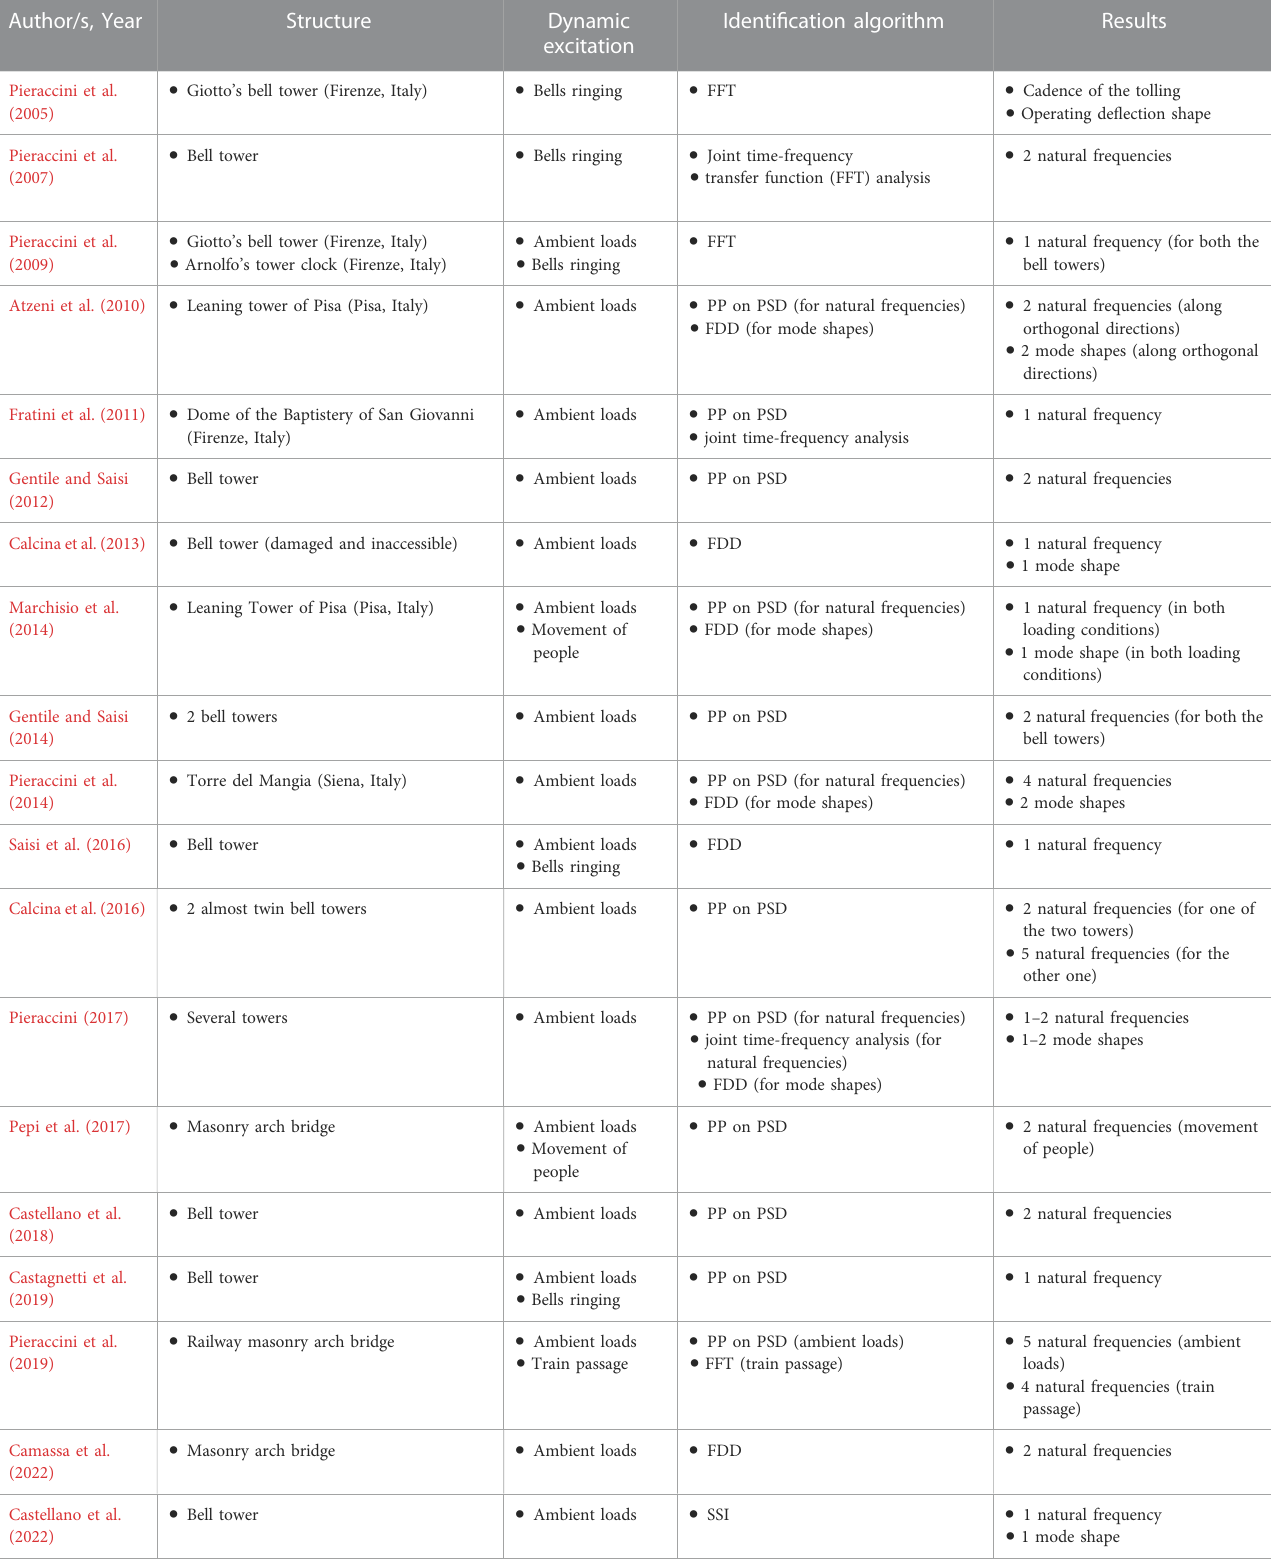
TABLE 1 Summary of the reviewed papers related to modal testing of masonry constructions by radar